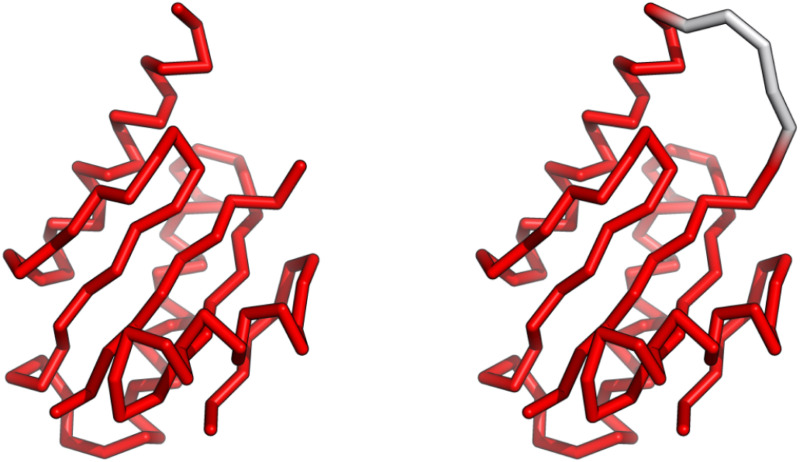
The coarse-grained Cα structures for the P domain from PDB (left) and modeling (right).Five glycines were added to connect the residue 10 to 77. The structure was used for the independent folding simulation of the P domain.